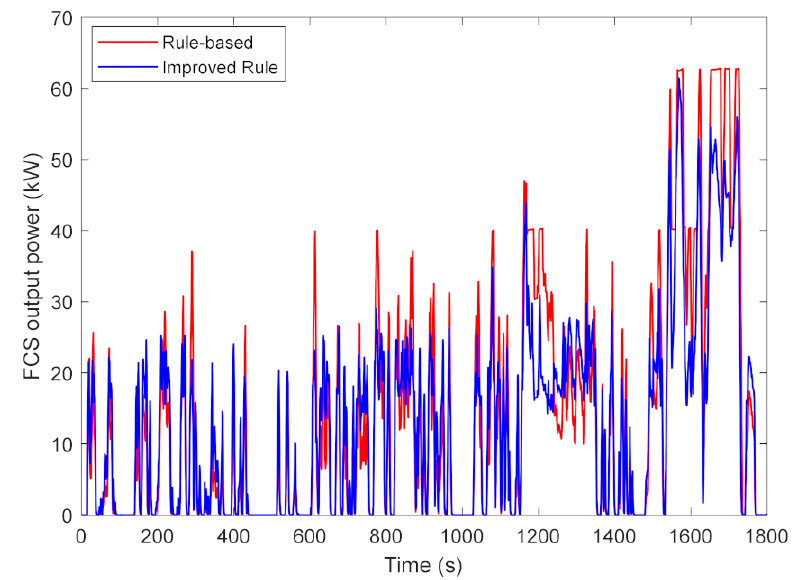
Figure 17. The fuel cell system output power before and after